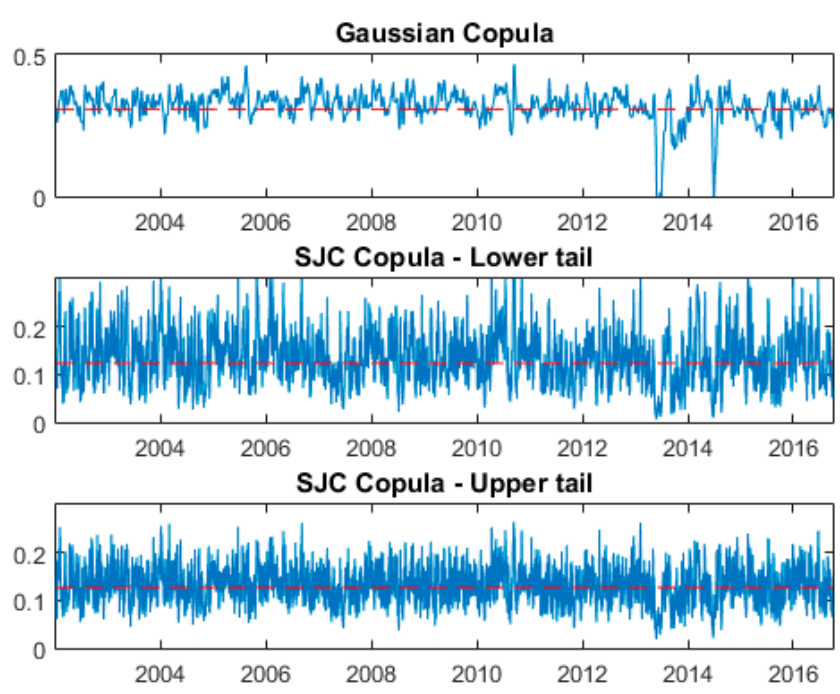
Figure 6. Dependence path of the time-varying copula for PM 10 –NO 2 .